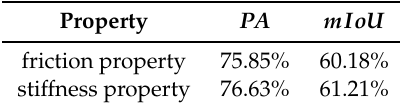
Table 11. Accuracy of the vision-based two-stage